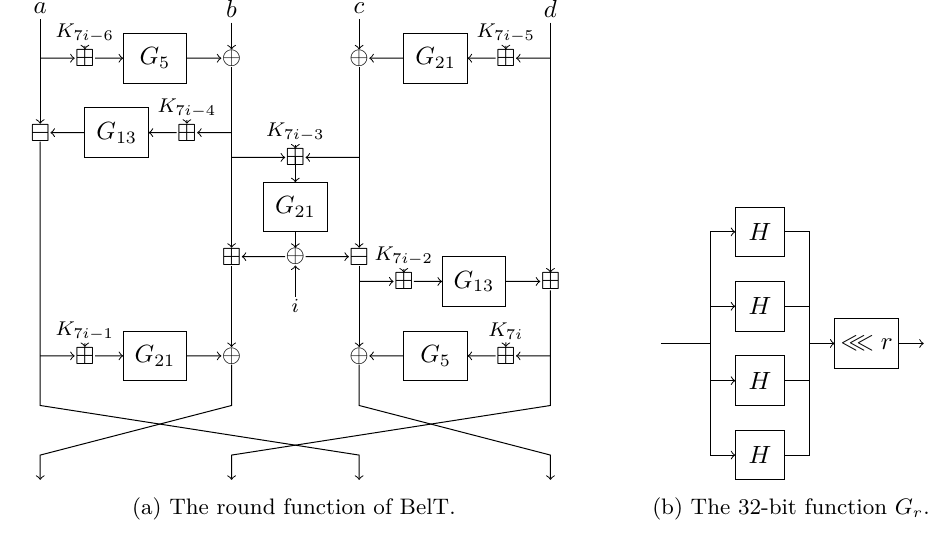
Figure 2: A high level view of